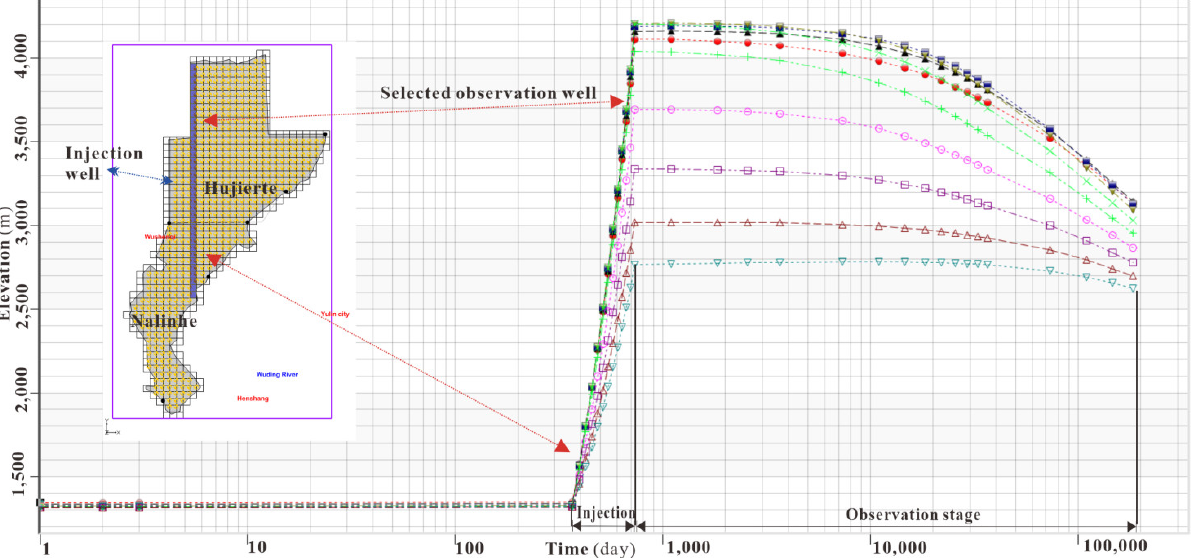
Figure 9. Wellhead water table of each stage in mine water injection activity. The ten observation wellhead table lines are evenly distributed in the selected observation grid row. Different line colors and logarithmic coordinates of x dimension are used to enhance the contrast.